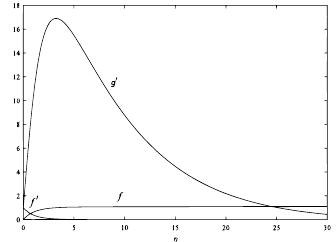
Figure 4. Impermeable surface, S = 0: profile plots of f , f (cid:48) and g (cid:48) against η for the upper branch solution with γ = − 0 . 01253 obtained from the numerical solution to equations (2.4)–(2.6),